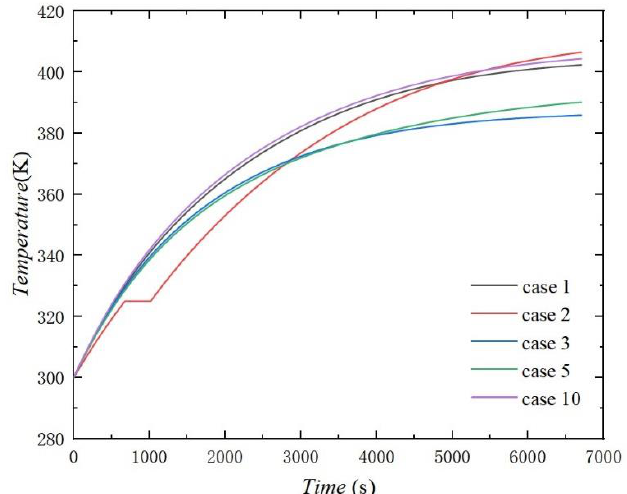
Figure 15. Temperature of accessory 1 with a single thermal protection measure.